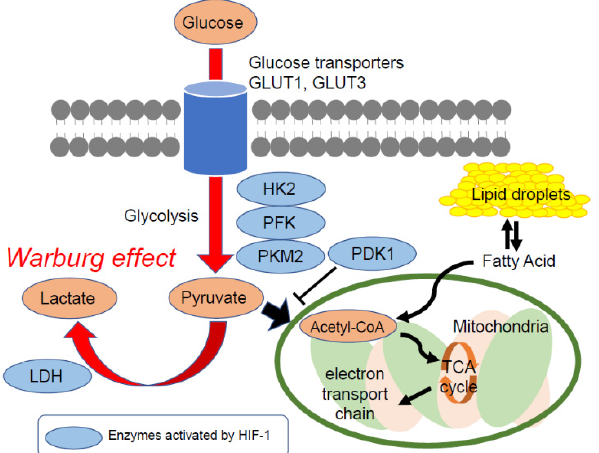
Figure 1. The Warburg effect and typical glucose metabolism in cancer cells. Cancer cells absorb higher levels of glucose than normal cells and generate energy by the non-oxidative breakdown of glucose (glycolysis). Cancer cells are generally found under hypoxic conditions, and glucose uptake and glycolytic pathway metabolisms are upregulated by hypoxia-inducible factor-1 (HIF-1). HIF-1 upregulates glucose transporter expression, such as GLUT1 and GLUT3, and increases glucose uptake. It also activates enzymes for glycolysis such as HK2, PFK, PKM2, and LDH. Lastly, HIF-1 J. Clin. Med. 2021 , 10 , 841 inhibits the pathway at the pyruvate conversion to acetyl-CoA step by activating PDK1.